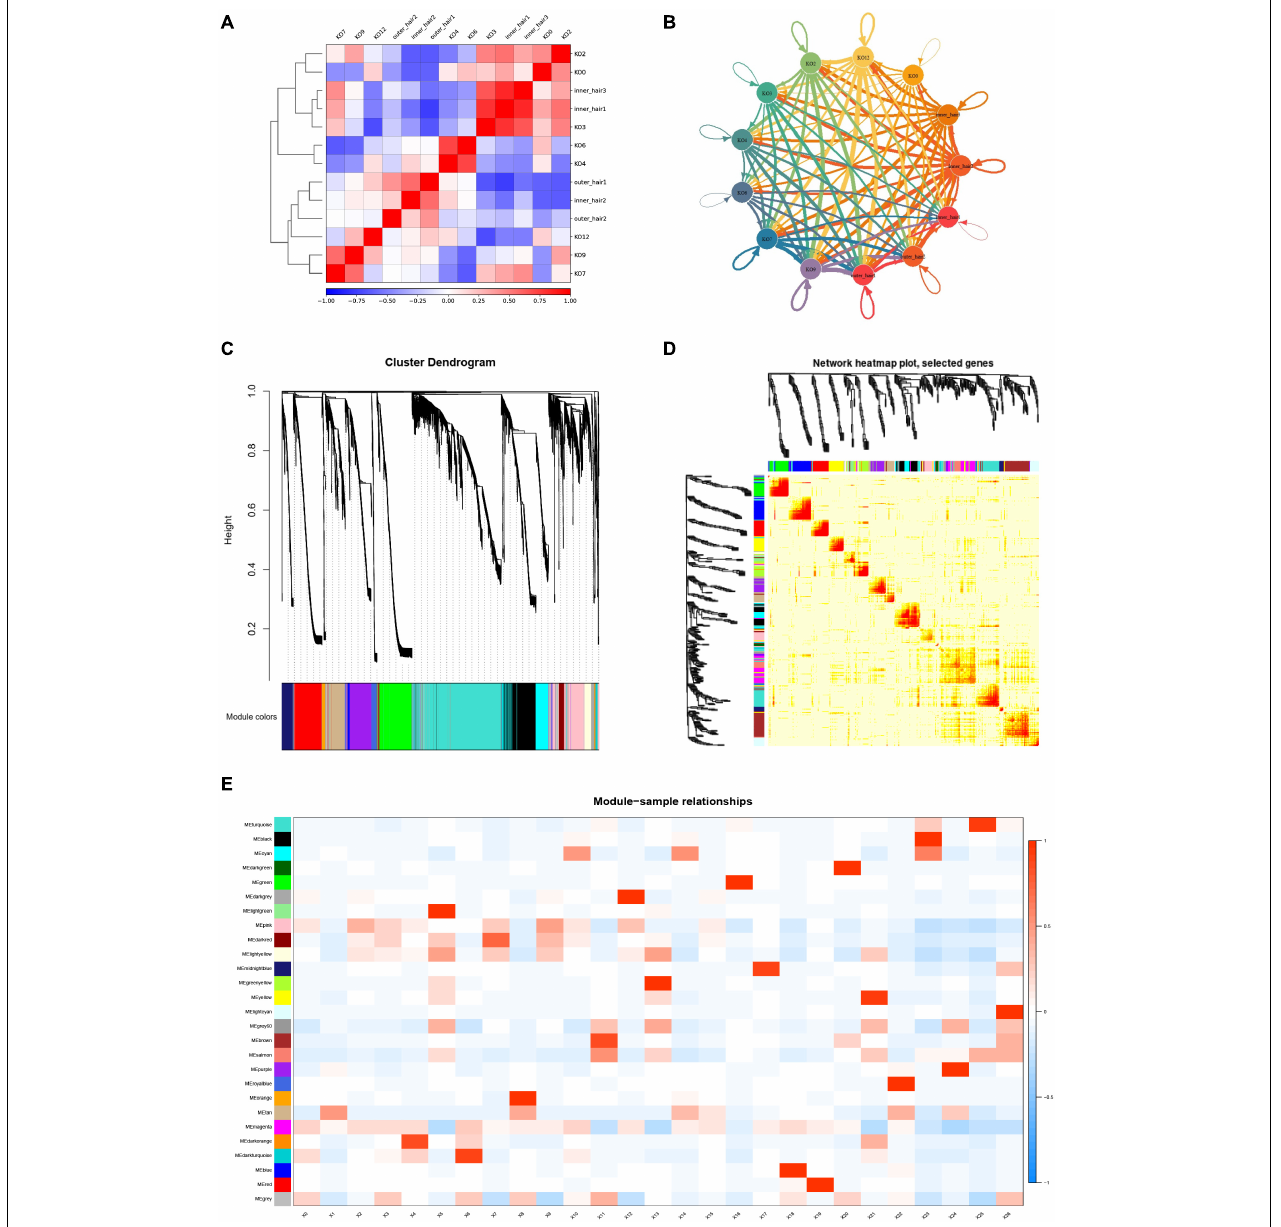
FIGURE 12 | Cell-cell communication networks and WGCNA analysis of KO cell clusters and hair cell clusters. (A) Heatmap in KOs and hair cells. The red color indicates a significant interaction. (B) Capacity for intercellular communication among KOs and hair cells. Each line color indicates the ligands expressed by the cell population represented in the same color (labeled). The lines connected to cell types expressed the cognate receptors. The line thickness was proportional to the number of ligands when cognate receptors were present in the recipient cell type. (C) The dendrogram of gene modules built by WGCNA. (D) Network heatmap plot. The module corresponds to branches. The bright red color of nodes represented stronger the genetic correlation of this module. (E) Module-trait relationship between different gene modules. The number in each cell represents the degree of correlation, and red means positive correlation at this stage; blue means negative correlation at this stage. Different colors represent the diverse specific gene modules detected by